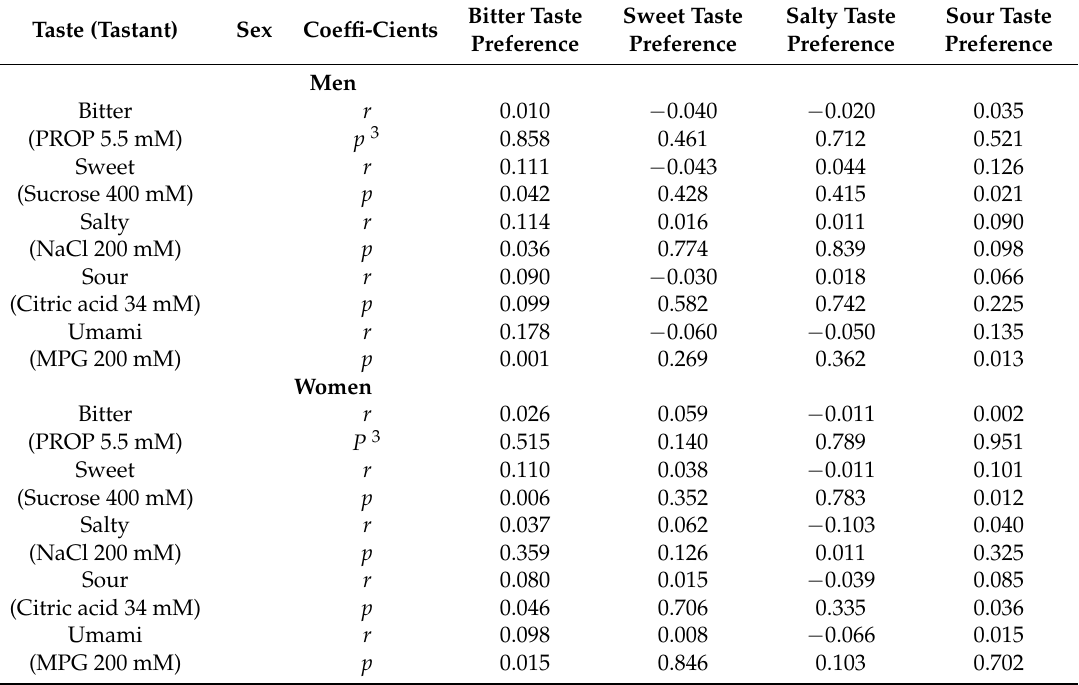
Table 6. Association between the perception of different tastants 1 and the taste preference by sex 2 . Taste (Tastant) Sex